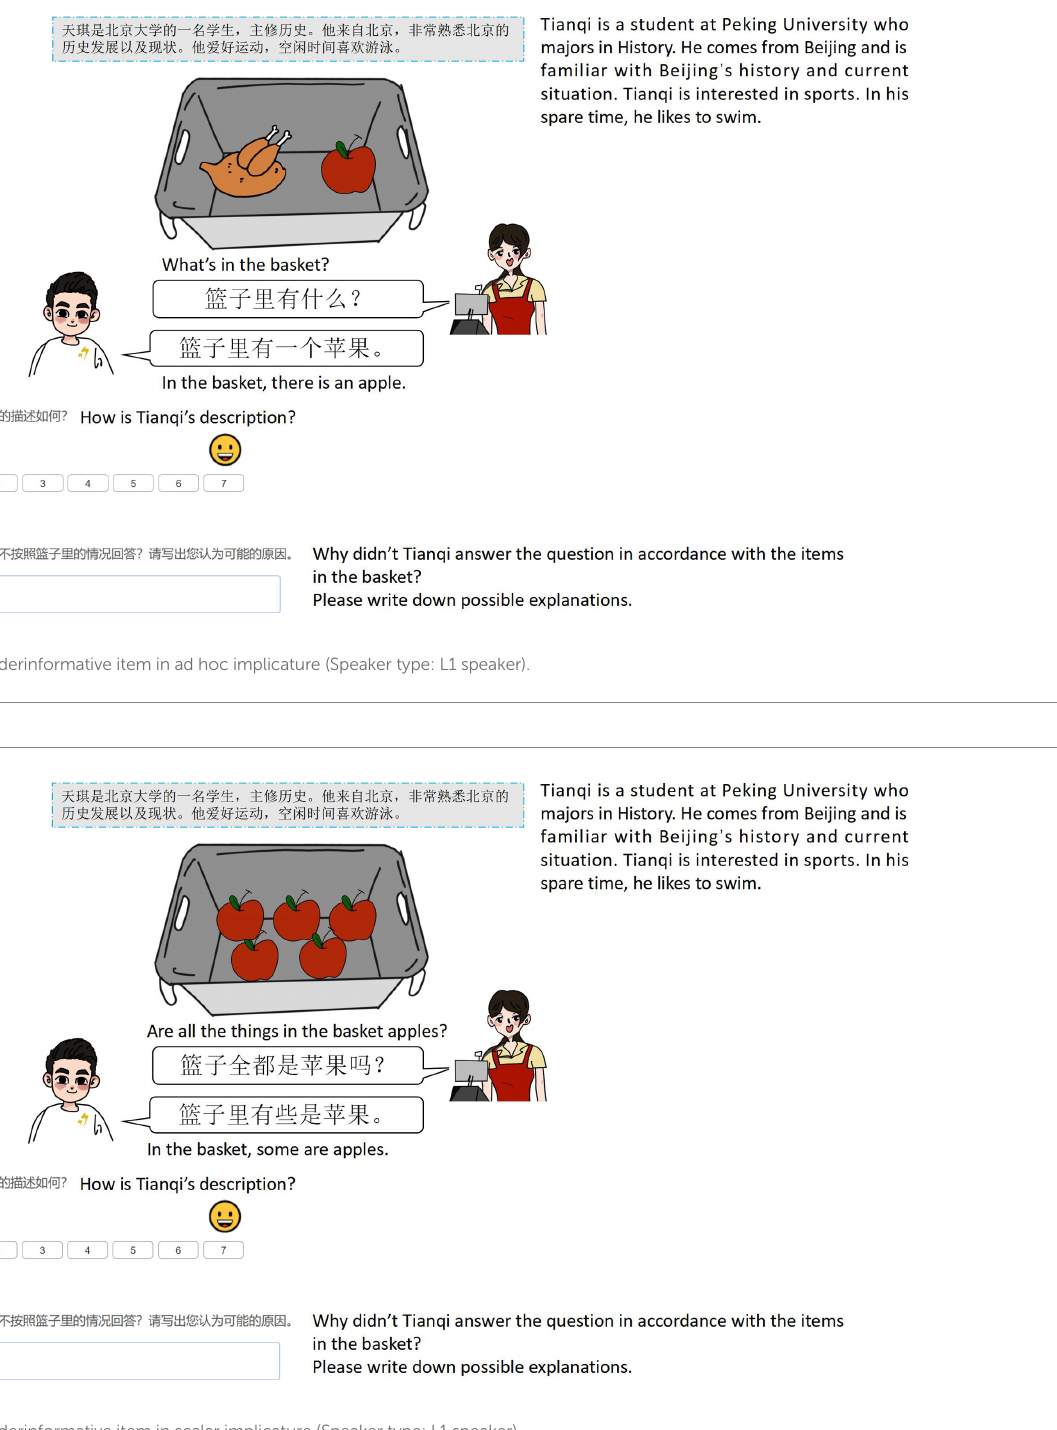
FIGURE 2 Sample display of an underinformative item in scalar implicature (Speaker type: L1